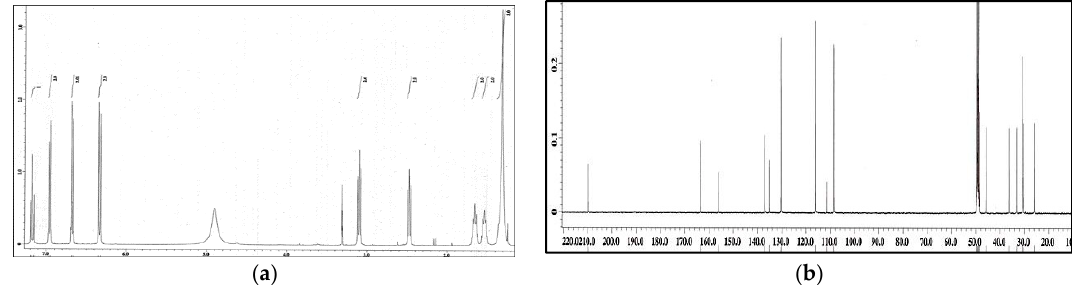
Figure 3. 1 H-NMR ( a ) and 13 C-NMR ( b ) spectra of compound 2 .